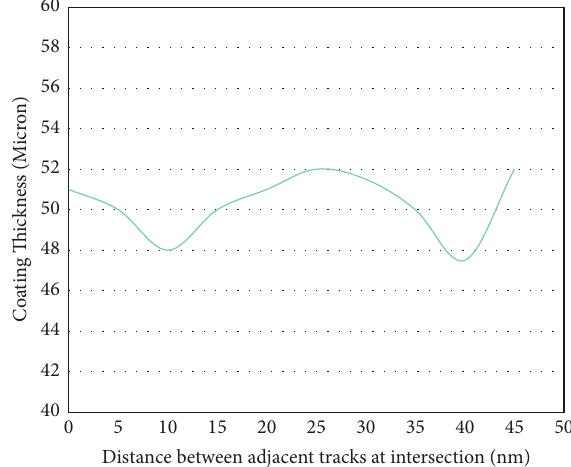
Figure 6: Coating thickness distribution at the intersection of the large-curvature cylindrical sheet and the approximately planar sheet.